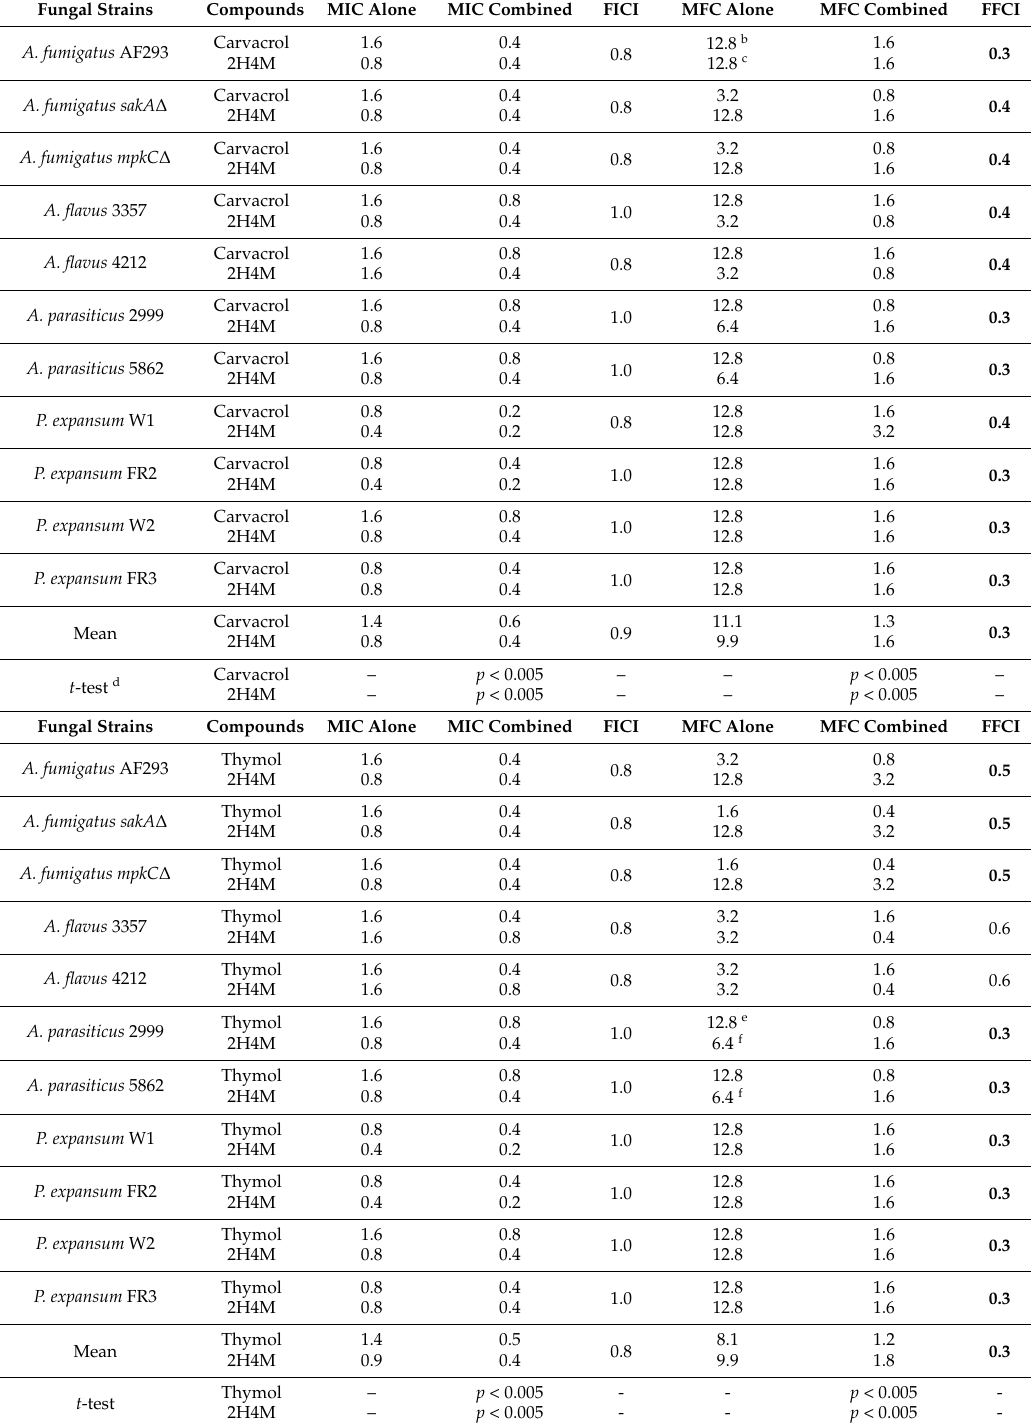
Table 5. Antifungal chemosensitization of 2H4M (mM) to carvacrol or thymol (mM), tested against Aspergillus and Penicillium strains: summary of CLSI-based microdilution bioassays. a Fungal